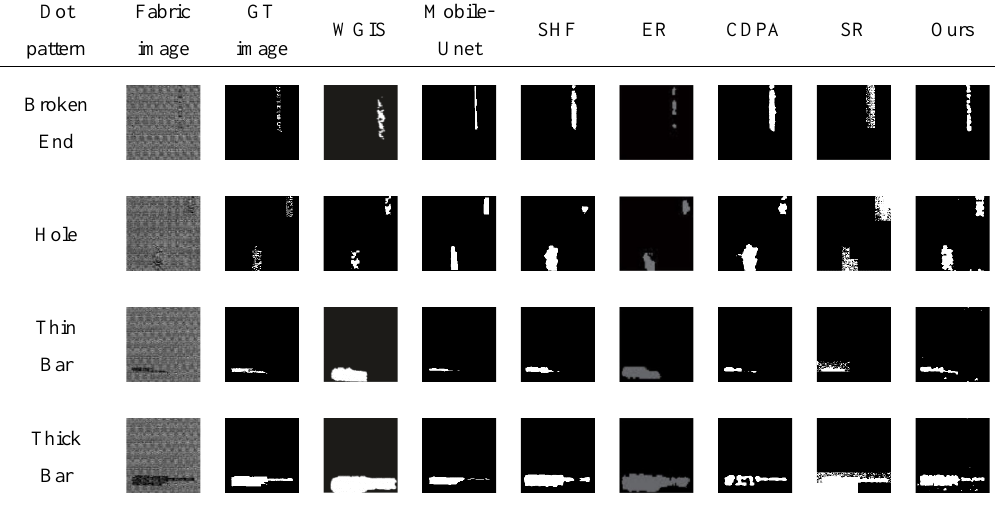
Figure 15. Each row depicts the detect inspection exemplars for 7 algorithms of a specific detection type. From top to bottom, these types are Broken End, Hole, Thin Bar and Thick